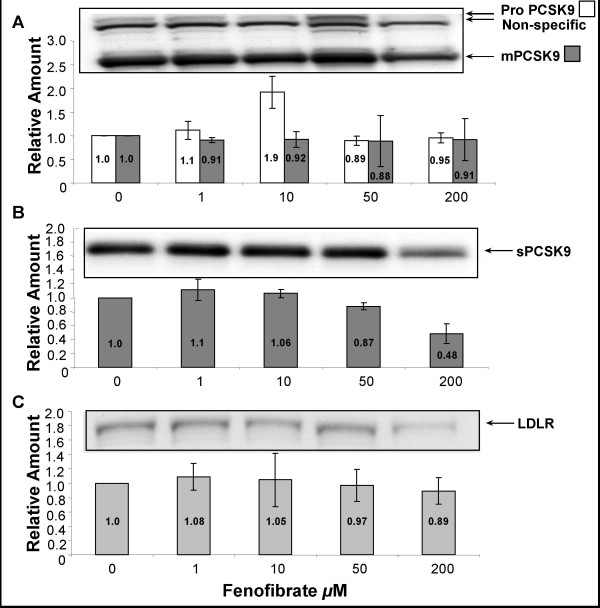
Effect of increasing concentrations of fenofibrate on PCSK9 and LDLR protein expression in HepG2 cells. Cells were grown in DMEM + 10% FBS and supplemented with increasing concentrations of fenofibrate for 24 hours at 37°C. 50 μg of total cell lysates (A and C) and 100 μl cell media (B) were analyzed by immunoblotting (IB), or immunoprecipitation (IP) followed by IB, respectively, as described in Methods. A and B were IB with anti-hPCSK9 Ab and C with anti-hLDLR Ab. The protein signals were quantified by densitometry using Syngene Chemigenius 2XE imager and Gene Tools software. All values were made relative to values from untreated cells set as 1 and presented as mean ± SEM (n = 3).